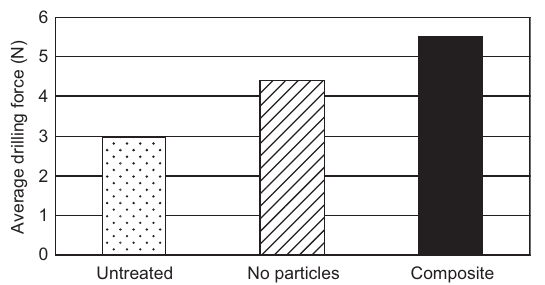
Figure 14 Average force needed to drill to a depth of 10 mm (i) an untreated mortar, (ii) the same mortar treated with a pure siloxane product (no particles), and (iii) the mortar treated with a composite, siloxane-nanoparticle, superhydrophobic